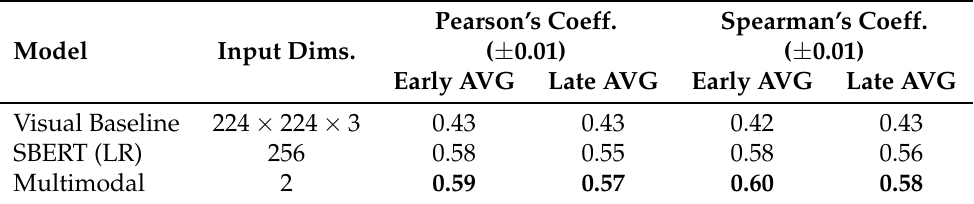
Table 2. Memorability prediction on Memento10K dataset using as input the average of the captions’ BERT embeddings against the visual baseline. Pearson’s Coeff. Spearman’s Coeff. Model Input Dims. ( ± 0.01) ( ±